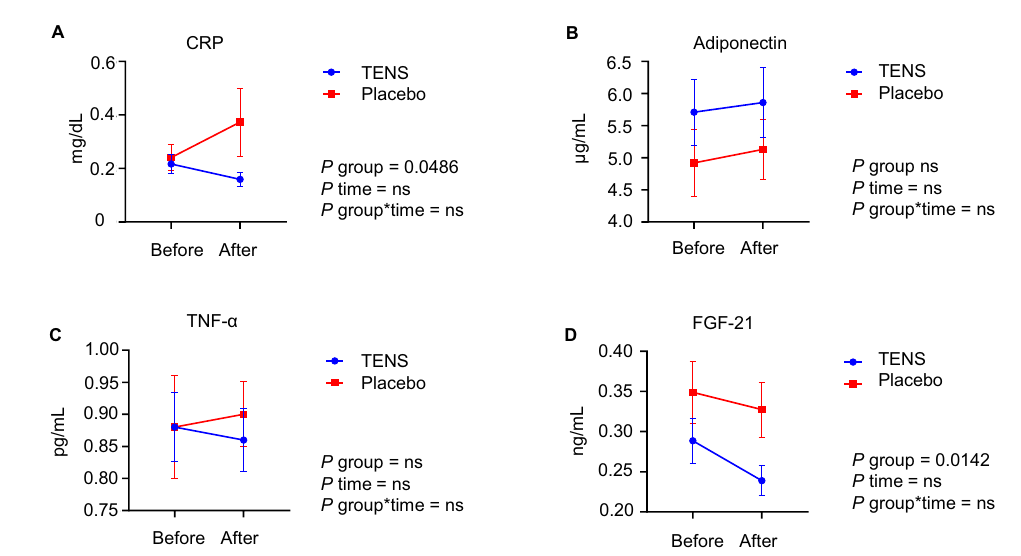
Figure 2. Change of exploratory parameters from before (week 0) and after (week 20) treatment in Transcutaneous Electrical Nerve Stimulator (TENS) vs. the placebo group. Statistical analysis with mixed model two–way ANOVA was carried out. Values are means ± standard error of mean (SEM), ns, non-significant. CRP, C-reactive protein; TNF-α, tumor necrosis factor-α; FGF-21, fibroblast growth